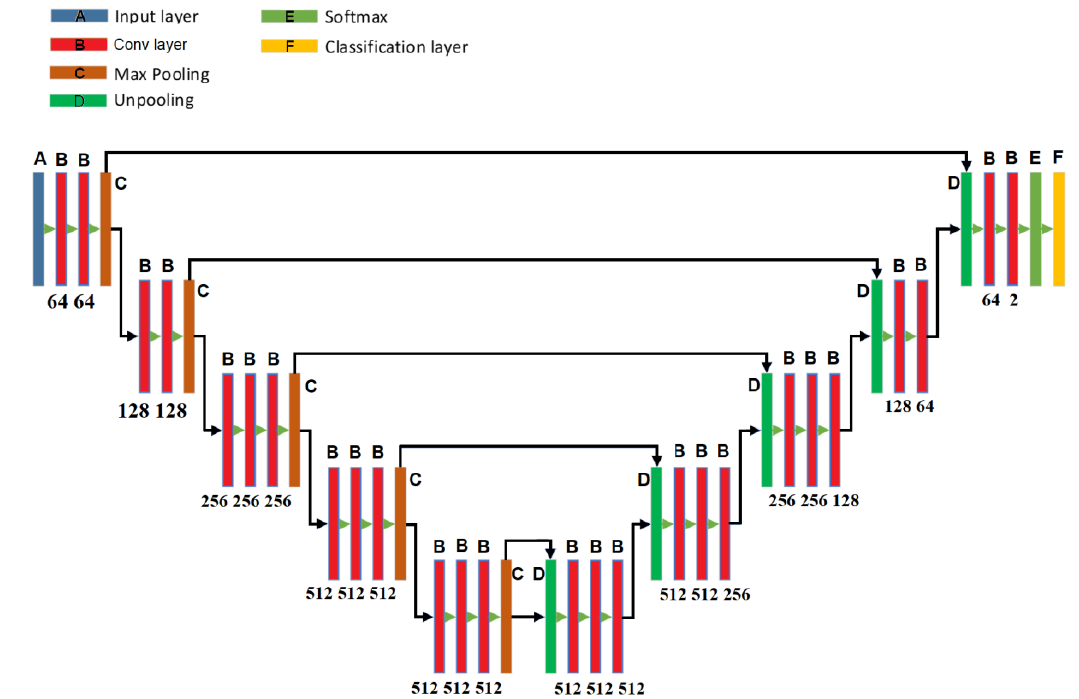
Figure 10. The architecture of SegNet used in the proposed system.